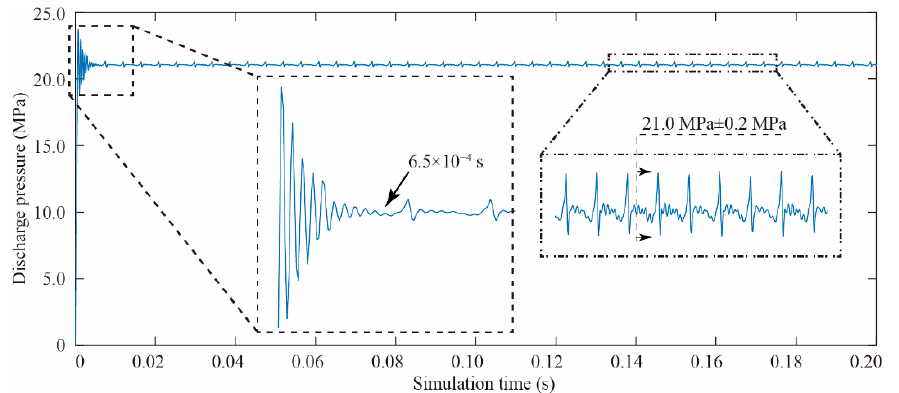
Figure 6. Simulated discharge pressure during the iterative process (normal pump model, rotational speed: 1500 r/min, discharge pressure: 21 MPa).